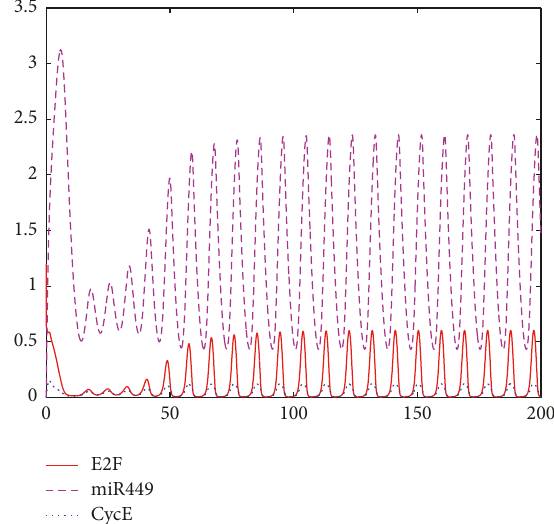
Figure 6: An asymptotically stable equilibrium for 𝜏 = 𝜏 1 = 𝜏 2 = 𝜏 = 0 .Assumeinitialconditionsare 𝑥 3 0, 𝑥 = 0, 𝑥 = 0.55, 𝑥 5 6